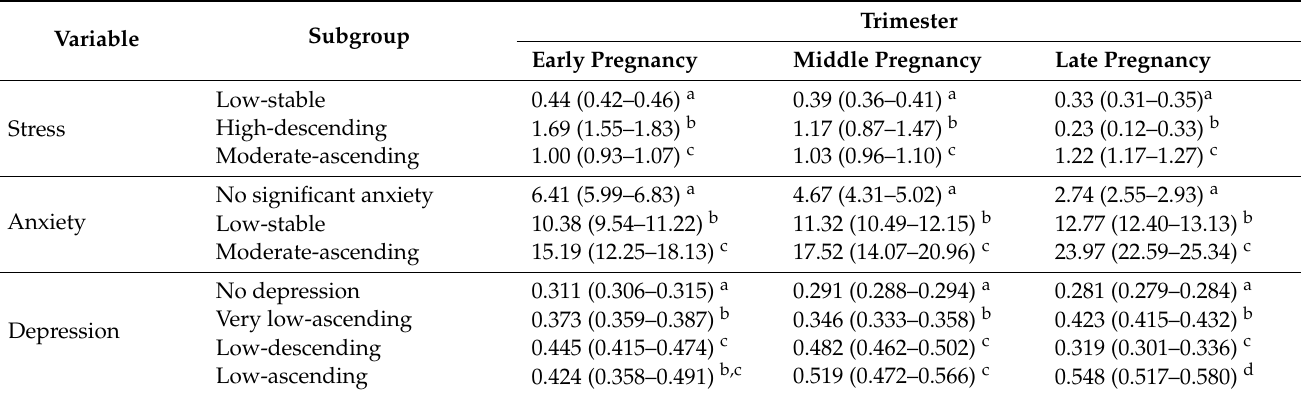
Table 2. Mean scores and confidence intervals for trajectory groups, and comparison of the subgroups of stress, anxiety, and depression at each follow-up